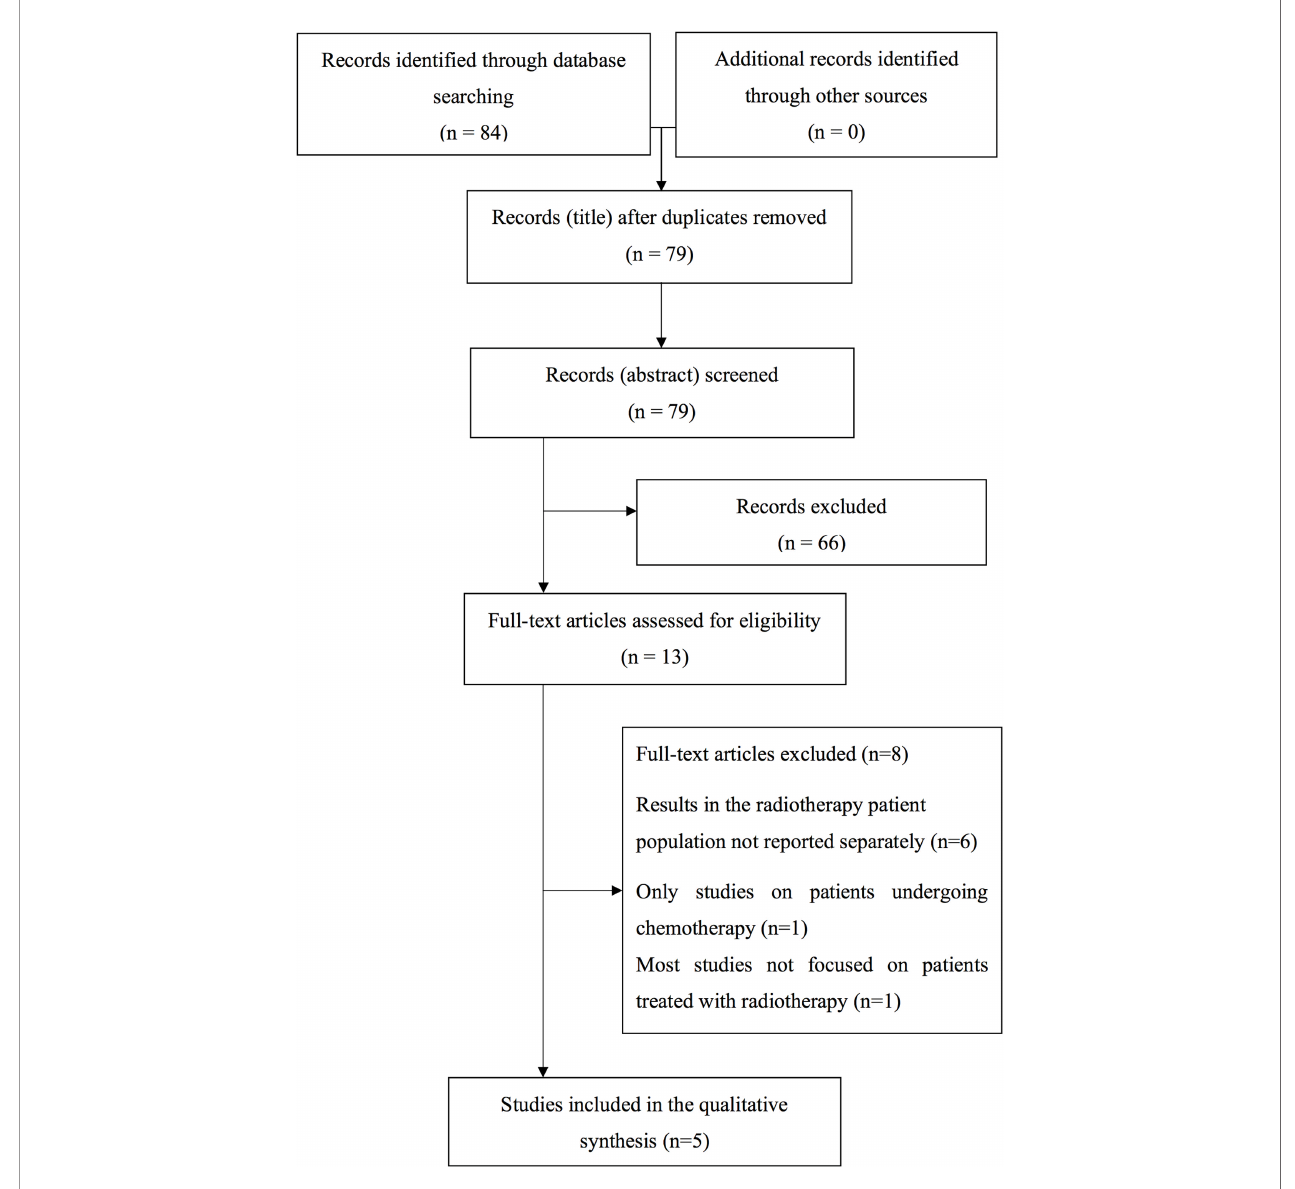
FIGURE 1 | Process of paper